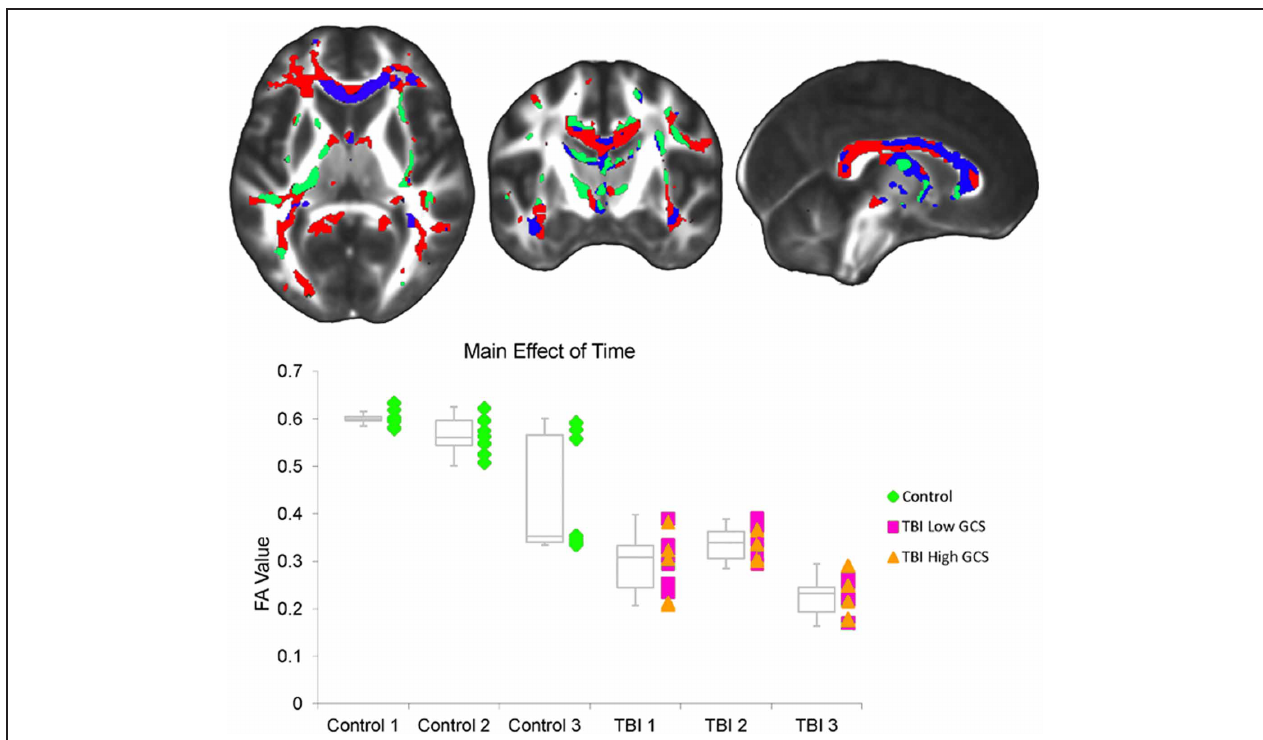
FIGURE 4 | (Top) A significant effect of group was observed within the FA factorial model in several white matter tracts throughout the brain, including the cerebral peduncle, inferior and superior longitudinal fascicule (ILF and SLF), internal and external capsule, inferior fronto-occipital fasciculus, sagittal stratum, corpus callosum, fornix, optic radiations, thalamic radiations, uncinate fasciculus, and corona radiata (red). Axial and radial diffusivity analyses were restricted to regions demonstrating an FA effect. Within this set of regions, a significant effect of group was also observed within the radial diffusivity factorial model (overlapping blue regions), as well as the axial diffusivity factorial model (overlapping green yellow regions). Regions in